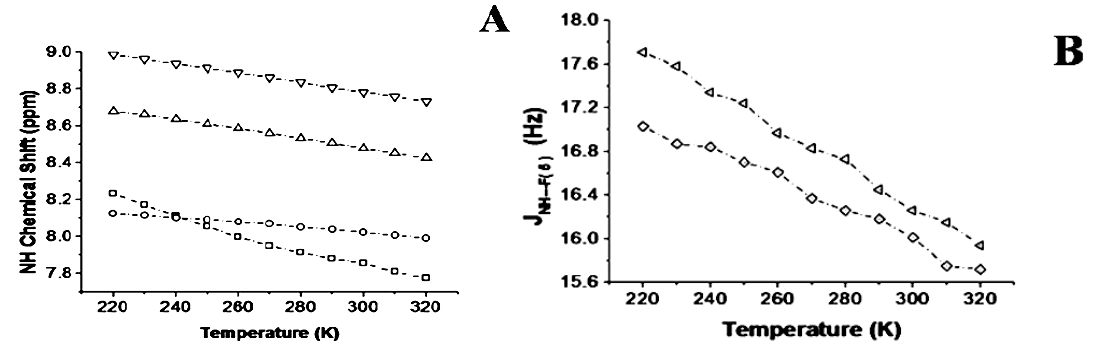
Figure 6. ( A ) Variation of chemical shift of NH protons ( δ NH ) with temperature for all the investigated molecules. The squares, circles, upper triangles and inverted triangles correspond to molecules 1 , 2 , 3 and 4 respectively; ( B ) The variation of 1h J N-H...F(5) , with temperature for molecules 3 and 4 . Squares pertain to molecules 3 and triangles correspond to molecule 4 .